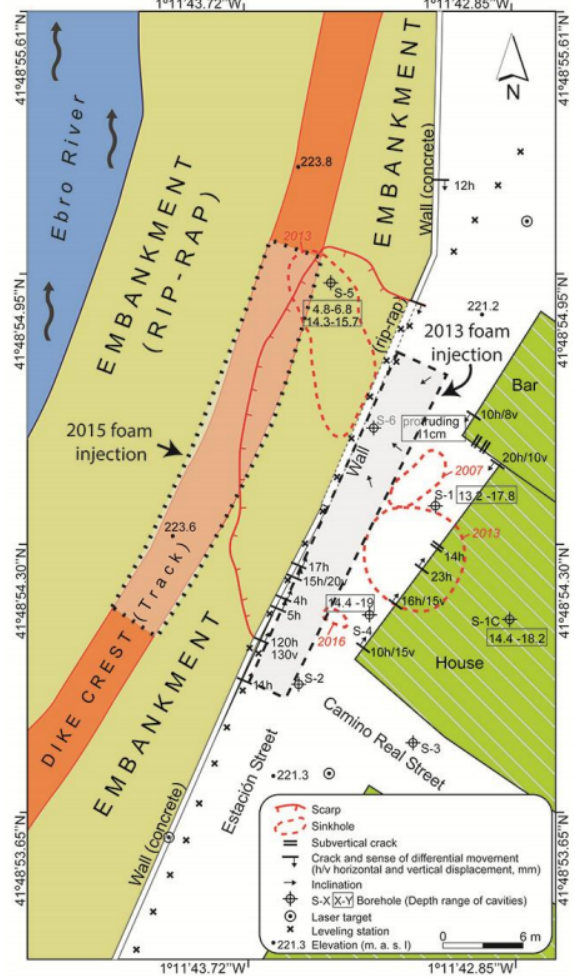
Figure 2. Detailed map of the Alcal á sinkhole produced in March 2016 showing the approximate locations of collapse events and remediation measures (compaction grouting with polyurethane foam), surface deformation features, positions of targets, leveling points and boreholes (numbers in parenthesis indicate the depth range of